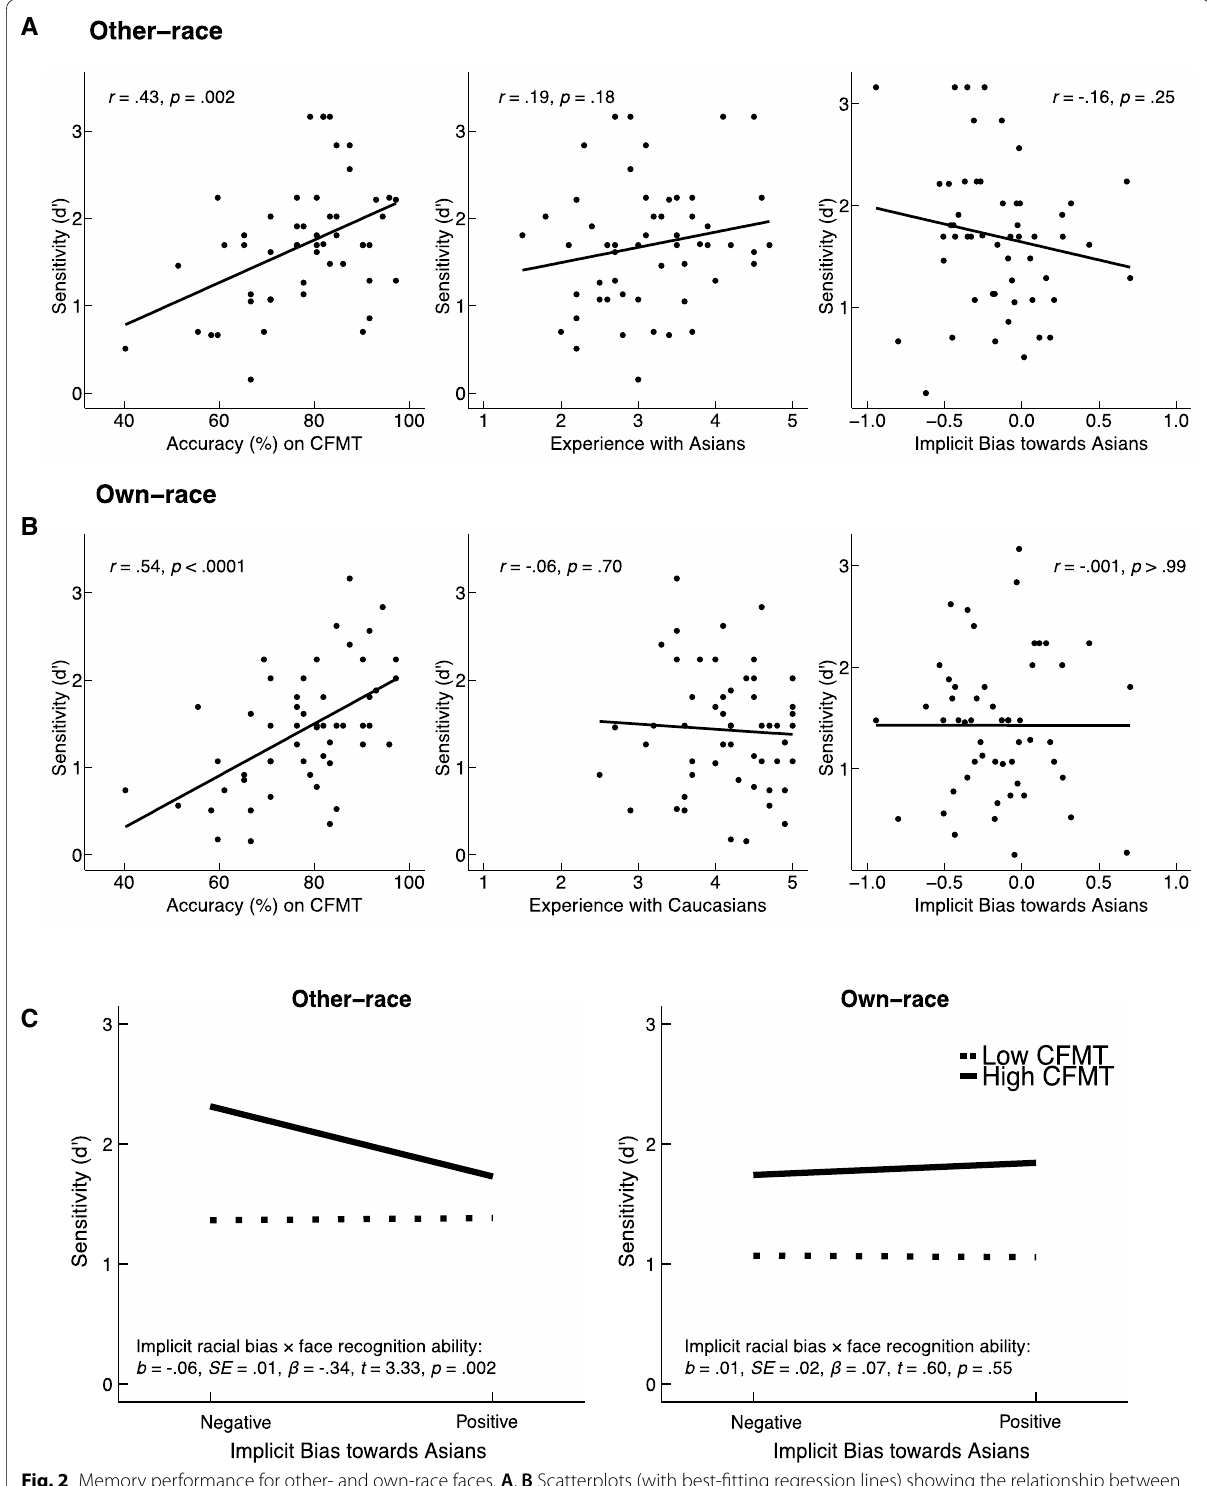
Fig. 2 Memory performance for other- and own-race faces. A , B Scatterplots (with best-fitting regression lines) showing the relationship between sensitivity (d’) in the memory task with face recognition ability, experience, and implicit racial bias for other-race faces ( A ) and for own-race faces ( B ). C Mean sensitivity (d’) as a function of 1 SD above and below the means of the measures of implicit racial bias (IAT) and face recognition ability (CFMT). For other-race faces, performance (d’) was predicted by all three factors (experience, implicit racial bias, and face recognition ability), and the interaction between implicit racial bias and face recognition ability. For own-race faces, d’ was only predicted by face recognition